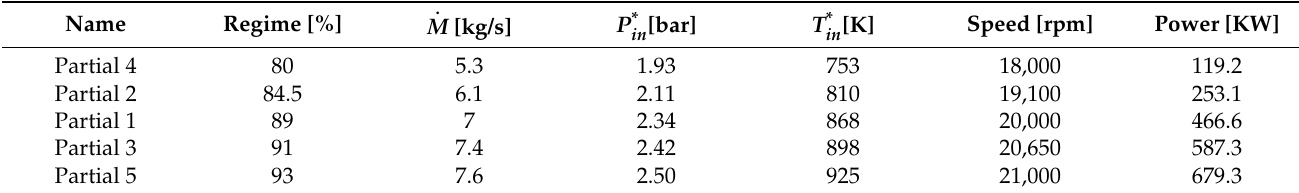
Table 5. Partial regimes parameters.